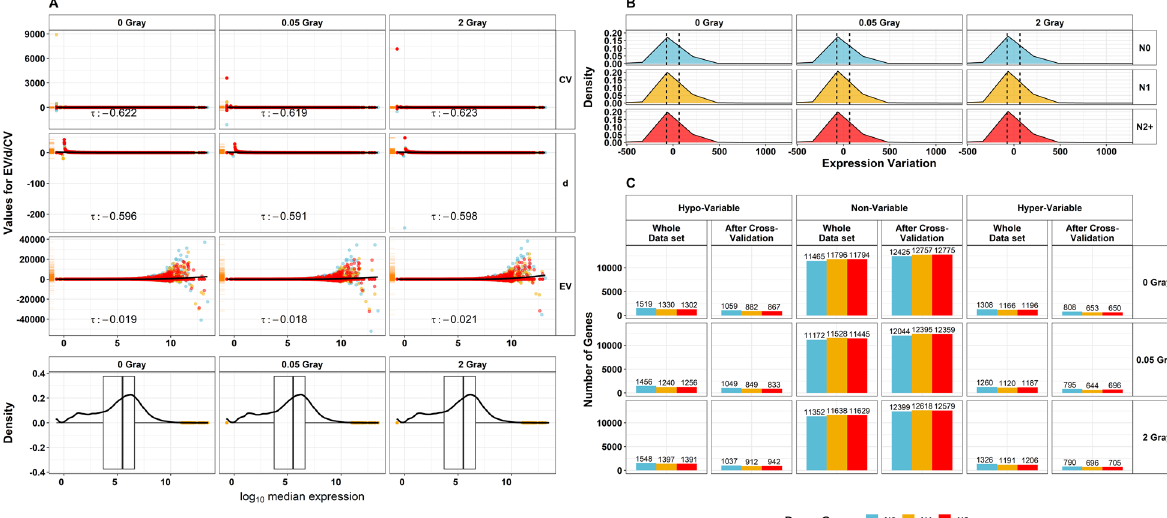
Fig. 1 Comparison of methods for quantification of expression variability and overview of distribution and subsequent variability classification: A Comparison of different metrics that are typically used for the characterization of expressional variability. Scatter plots showing the association of the coefficient of variation (CV, standard deviation/mean), standardized median absolute deviation (d, median absolute deviation (MAD)/ median), and expression variability (EV, computed as MAD observed ‑MAD expected ) on the respective y‑axes with the median expression on the x‑axis. Kendall’s correlation coefficient (τ) for the correlation of each variability metric with the median gene expression is provided per facet. The yellow stripes on the left show the value distribution of each variability metric. The colours of the dots represent the donor groups (N0 cancer‑free controls, N1 fibroblasts of childhood cancer survivors without a second primary neoplasm, N2 = survivors with at least one second primary neoplasm) Below, the distribution of the median gene expression is presented as box‑ and density plots. B Density plots showing the distribution of the EV (truncated using the smallest Q 01 (N0 after LDIR) EV 2 Gray) EV 1204.8 for reasons of legibility), also stratified by donor group, and radiation dose. Dashed lines imply the ranges employed for the = classification into hypo‑, non‑, and hyper‑variable, whereas genes with an EV lower than the left dashed lines were classified as hypo‑variable and genes with an EV higher than the right dashed line were conversely classified as hyper‑variable. Genes with an EV between the dashed lines were classified as non‑variable. C Bar charts showing the number of genes that were classified as hypo‑, non‑, and hyper‑variable, using the whole data set and the number of genes with stable classification confirmed by cross‑validation. All data were stratified by exposed radiation dose (0, 0.05, and 2